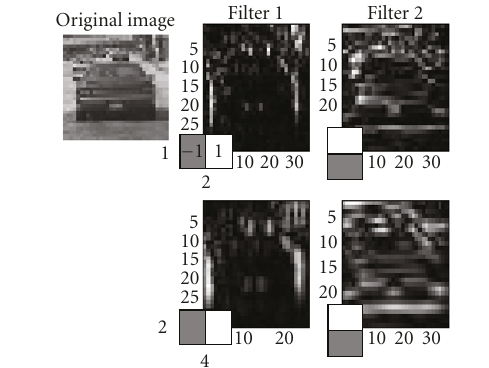
Figure 3: Original image and di ff erent image windows obtained by applying the vertical and horizontal Haar